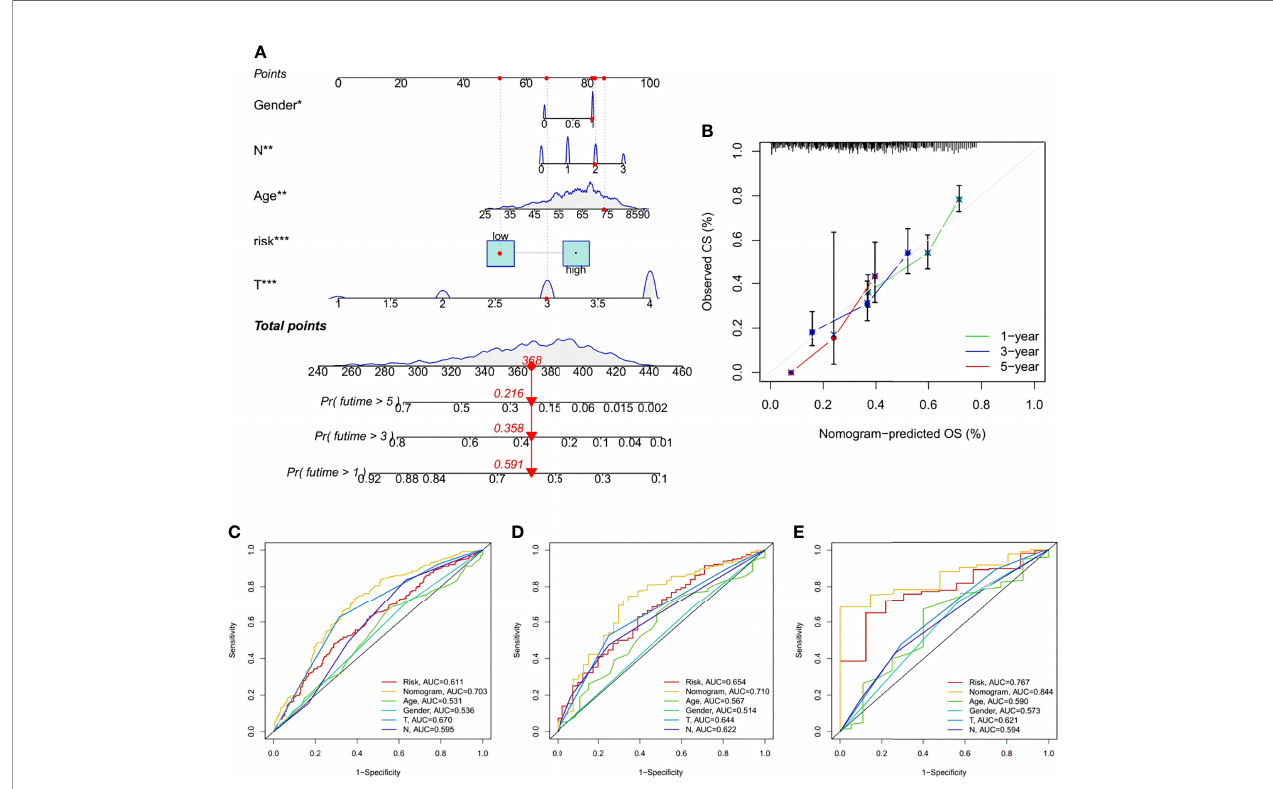
FIGURE 11 | Construction and validation of a Nomogram. (A) Nomogram for prediction of 1-, 3-, and 5-year survival rate of STAD patients in the training set. (B) Calibration curves of the Nomogram for prediction of 1-,3-, and 5-year survival in the training set. (C – E) ROC curves for the sensitivity of different approaches in predicting the prognosis based on 1-, 3-, and 5-year survival rate of STAD patients in the training, testing, and all sets,